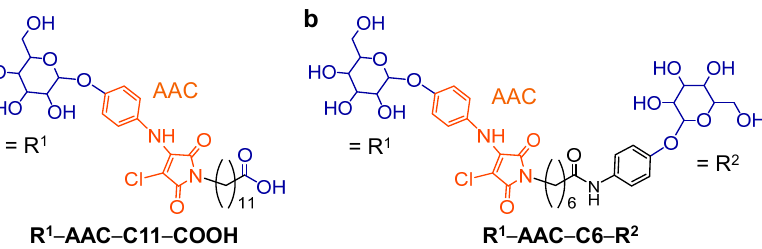
Figure 1. Chemical structures of bola-amphiphilic glycolipid-type hydrogelators possessing an N -alkyl-2-anilino-3-chloromaleimide (AAC) moiety (R 1 , R 2 = α - or β - D -glucose ( α / β Glc), α - or β - D -galactose ( α / β Gal); ( a ) R 1 –AAC–C11–COOH [36], ( b ) R 1 –AAC–C6–R 2 [40].